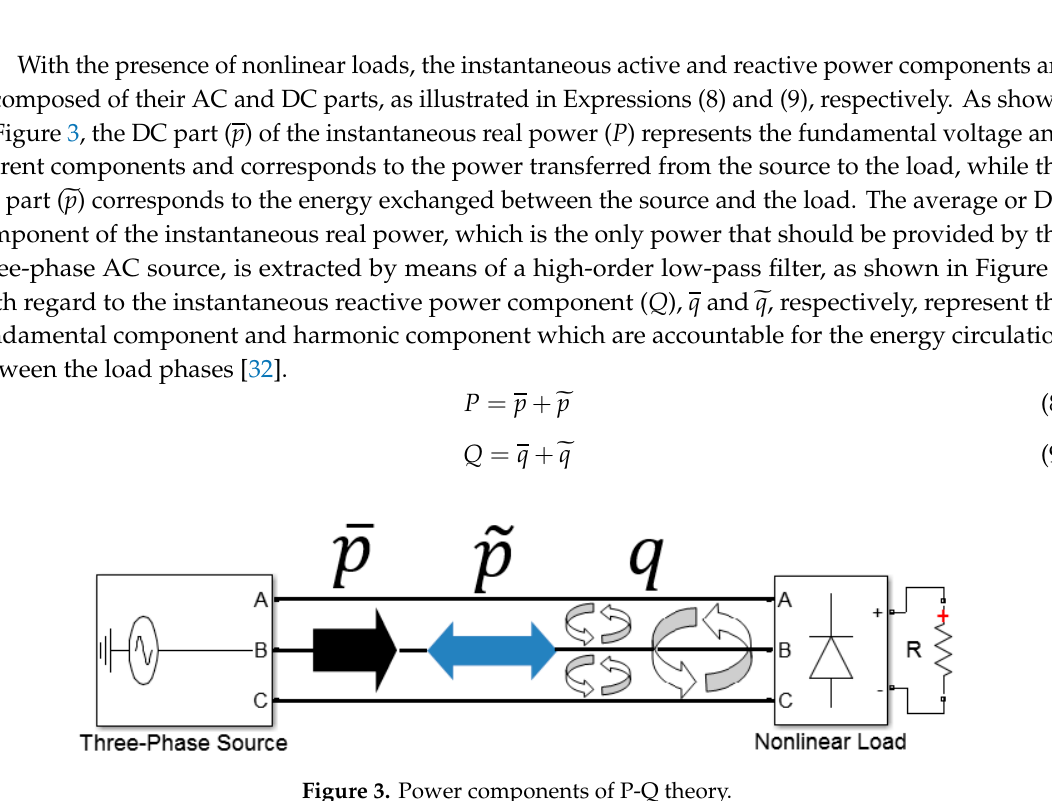
Figure 2. Block diagram of the active and reactive power theory.